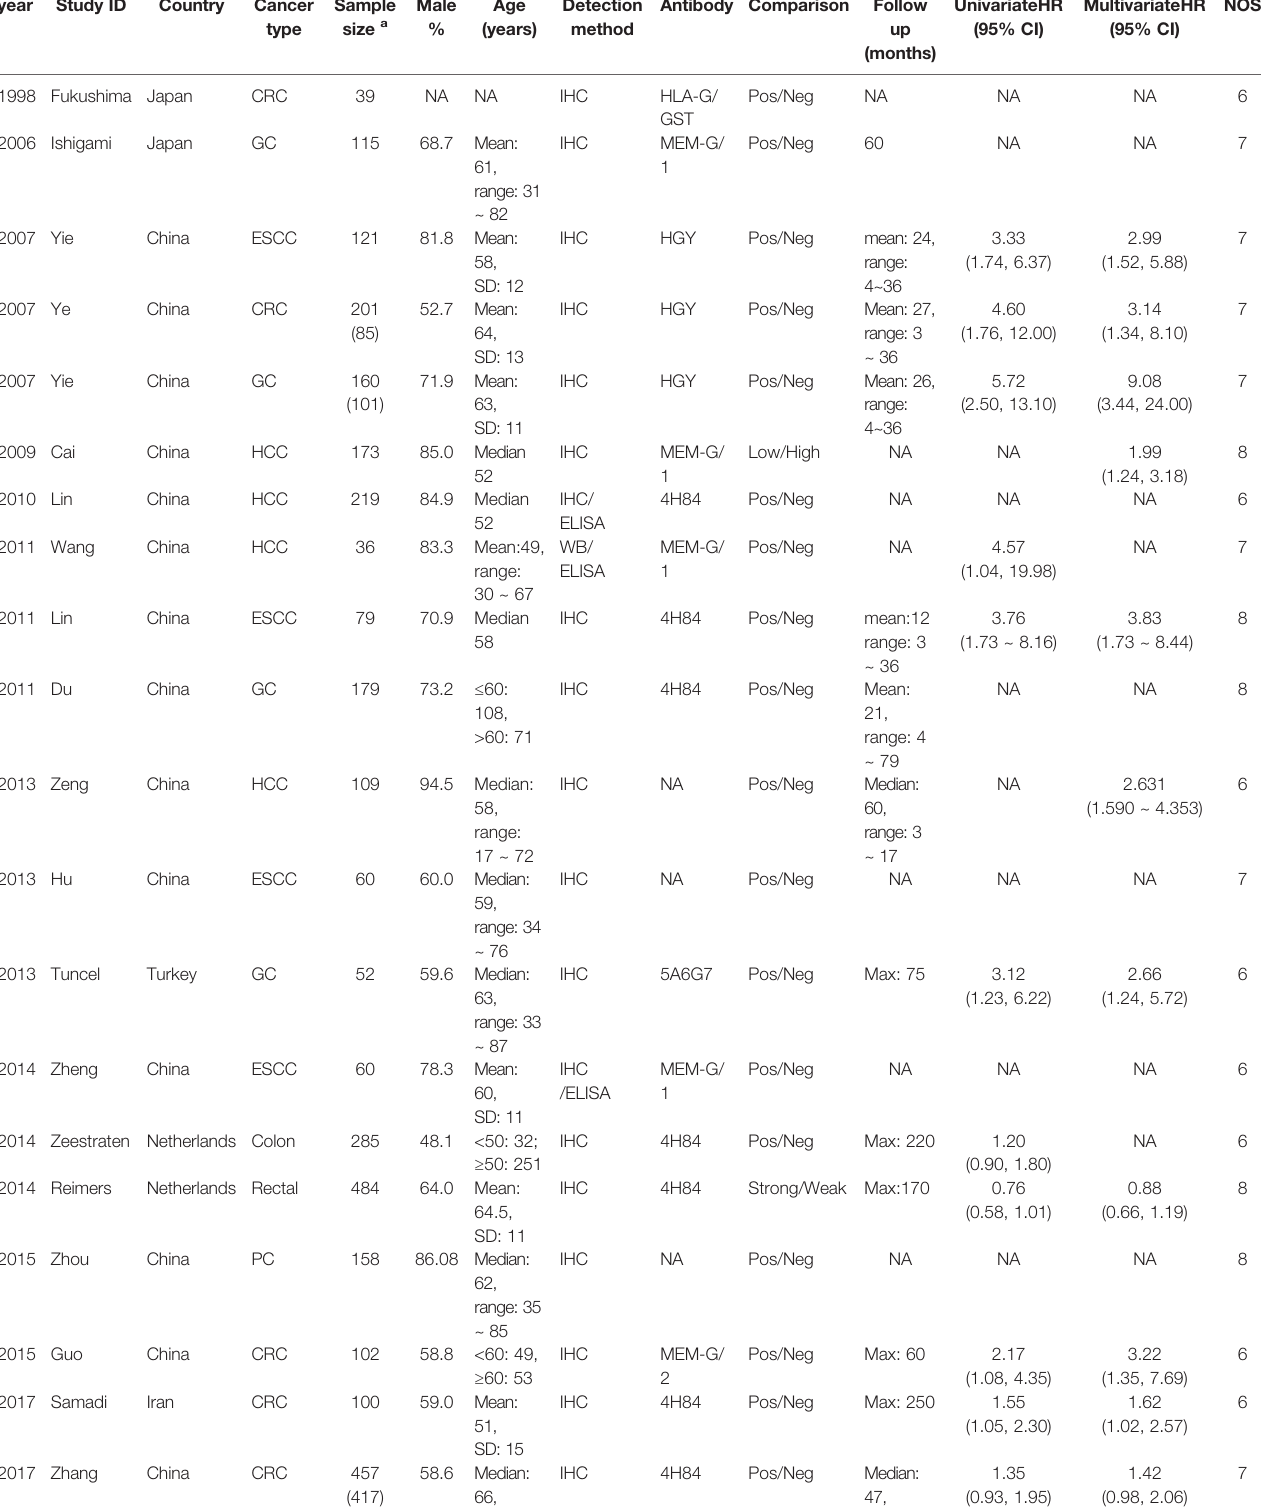
TABLE 1 | Characteristics of the included